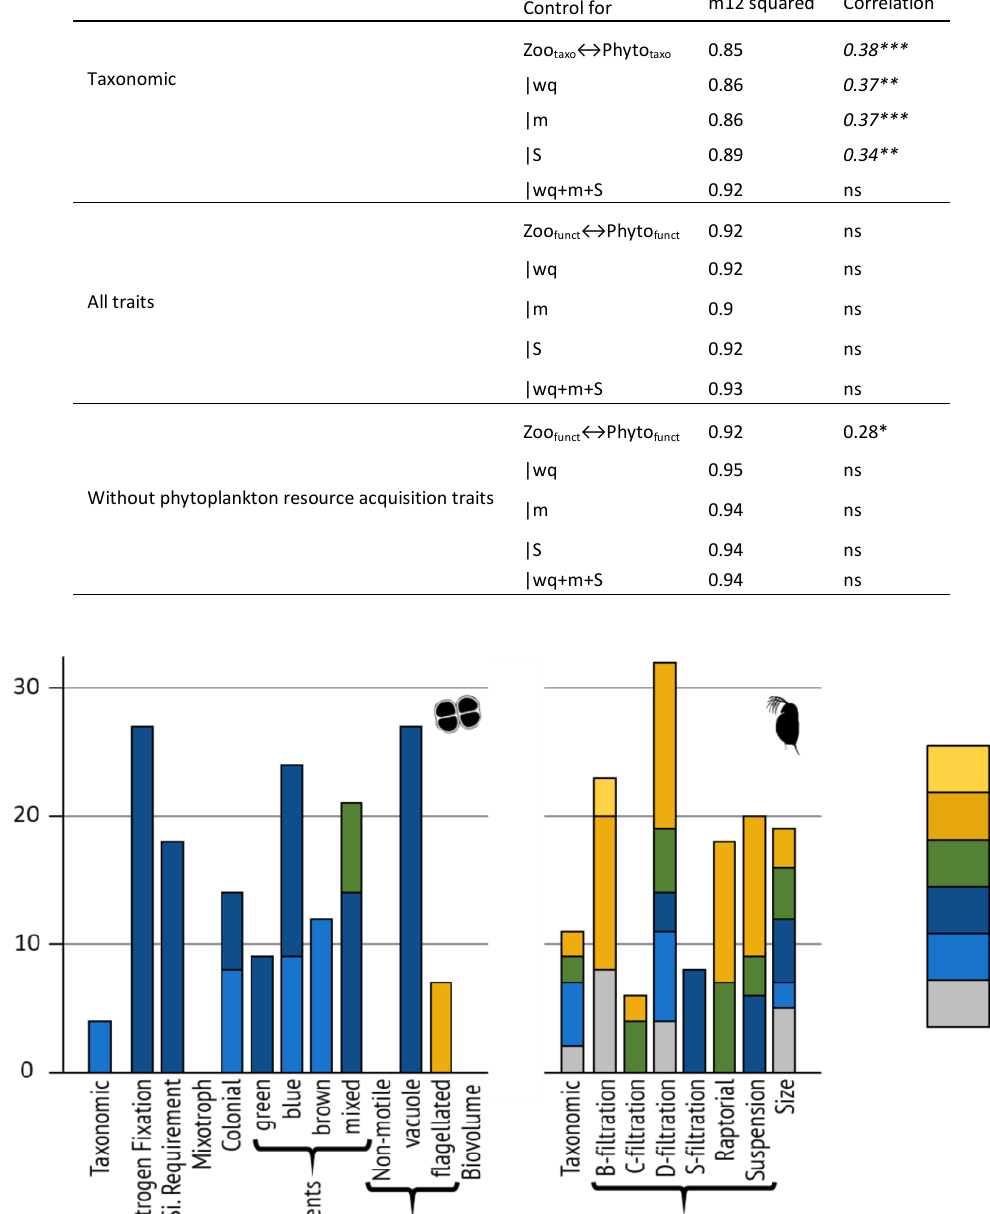
Table 3: Procrustes rotation analysis of species and the trait dataset correlation coefficients for phytoplankton (Phyto) and zooplankton (Zoo) after controlling (|) for water quality (WQ), morphometry (M) and space (S). Where * = 0.01<p<0.05, ** = 0.001<p<0.01,*** p<0.001, ns = non-significant.